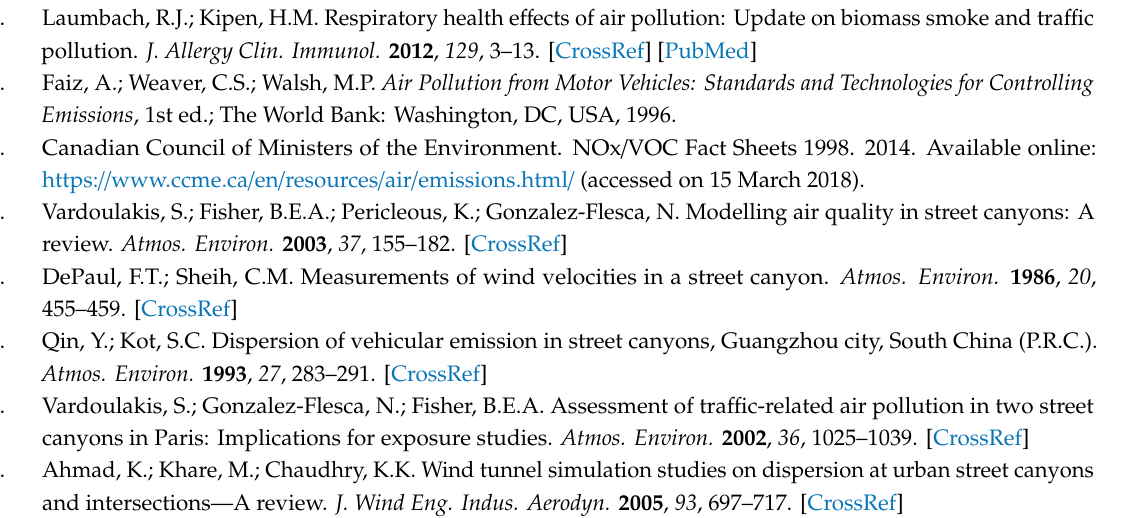
Figure S1: Boundary conditions for air temperature and wind speed at 08:00, 12:00, 16:00, and 20:00 JST. Figure S2: Boundary conditions for NO, NO 2 , and O 3 concentrations at 08:00, 12:00, 16:00, and 20:00 JST. Figure S3: Spatial distributions of mean NO x emission intensity in CMAQ modeling domains from D1 covering East Asia to D7 covering Osaka Prefecture, and locations of observation sites in Osaka City used for model validations. Figure S4: Diurnal variations of the CMAQ-simulated and observed NO 2 / NO x concentration ratio at the Kokusetsu-Osaka station for monitoring ambient air pollution on 23 August 2010. Figure S5: Diurnal variations of the CMAQ-simulated, observed and CFD-simulated NO 2 / NO x concentration ratio at the Umeda-Shinmichi station for monitoring roadside air pollution on 23 August 2010. Figure S6: Vertical air temperature profiles at 08:00, 12:00, 16:00, and 20:00 JST on National Route 25 for the points ( a ) P 1 located at y = 230 m; ( b ) P 2 located at y = 350 m; ( c ) P = 390 m. Table S1: WRF and CMAQ 3 located at y